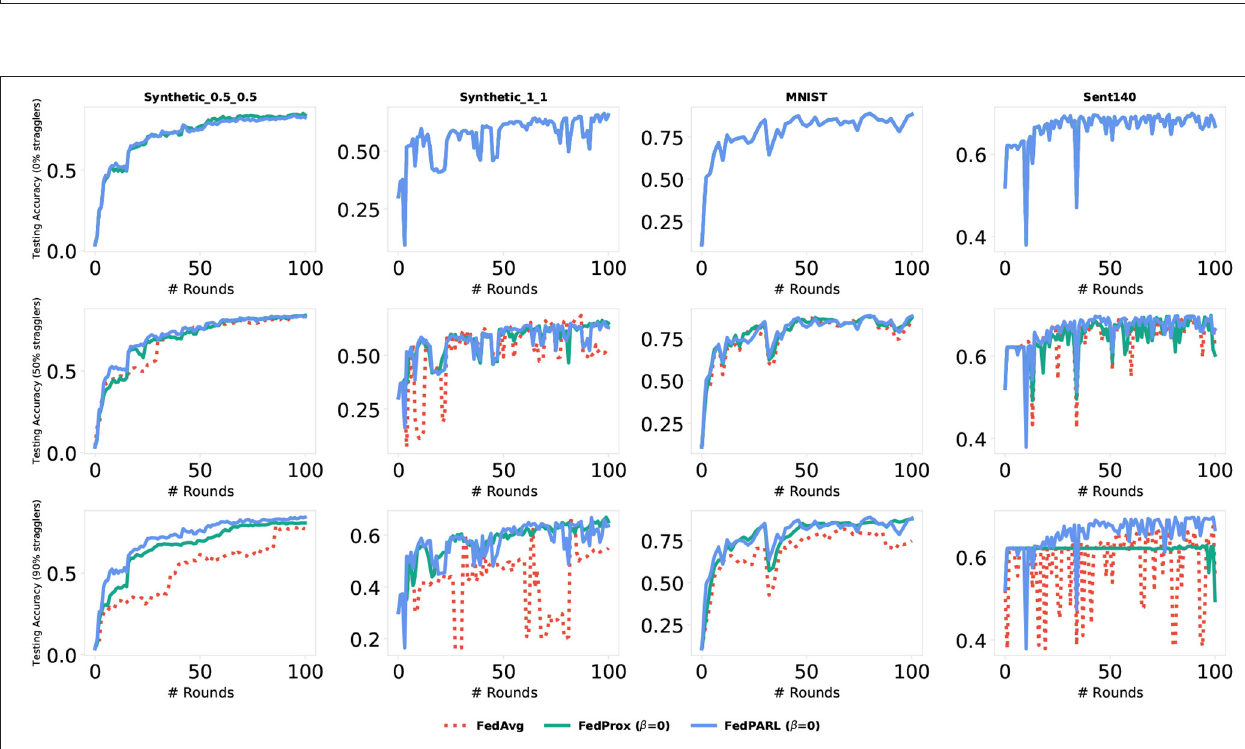
FIGURE 11 | Comparison of testing accuracy of our proposed FedPARL framework (considering no proximal term, i.e., β presence of different percentages of stragglers (i.e., 0, 50, and 90%).